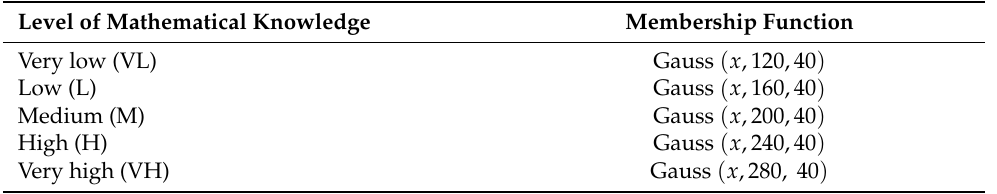
Table 3. The fuzzification of students’ achievements in the INVALSI test.